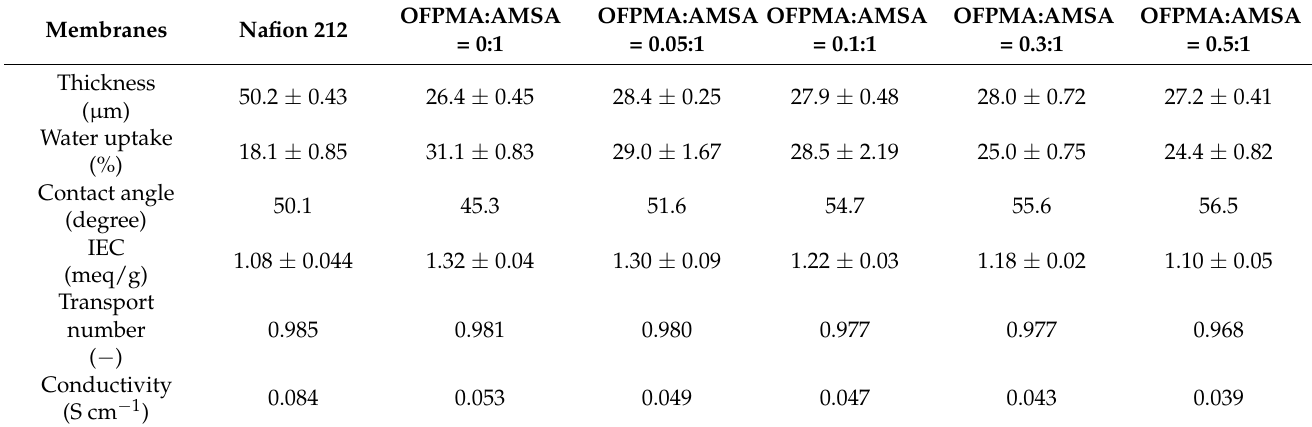
Table 2. Various characteristics of commercial and prepared membranes.